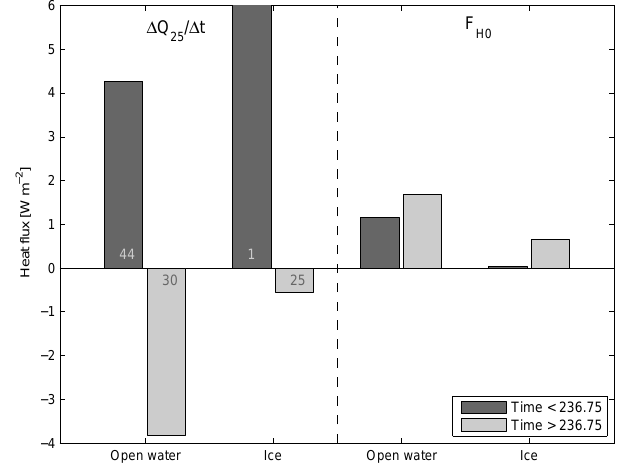
Fig. 14. (a) Change in heat content ( 1H 20 /1t ) in the upper 20m and (b) ocean heat flux ( F H 0 ) averaged according to flow direction and period before and after doy 236.75. Change in heat content was calculated within 3-h intervals and the average current direc- tion within the same period was used to classify the flow from the mostly open water covered area or the flow from the ice covered area. Numbers on the 1H 20 /1t bars indicate the number of 3-h intervals that were averaged. 1H 20 /1t from the ice before doy 236.75 extends outside the axis with a value equal to 10Wm − 2 , but was discarded since it contained only one 3-h